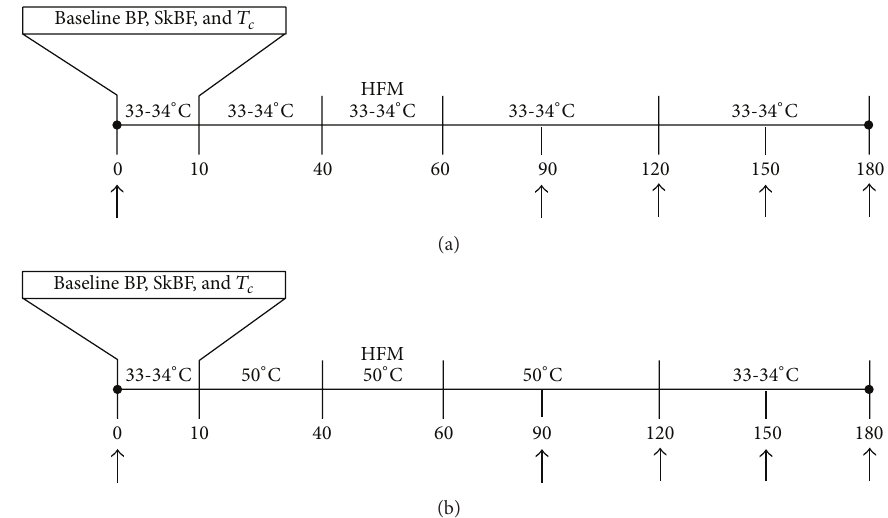
Figure 1: Schematic illustration of the experimental protocol. (a) HFM (thermoneutral) protocol and (b) HFM-TT protocol. Arrows indicate time points where finger stick blood samples were taken. Temperatures of 33-34 ∘ C (thermoneutral) and 50 ∘ C (thermotherapy) indicate the temperature of the water pumped through water-perfused suit. BP: blood pressure; SkBF: skin blood flow; 𝑇 𝑐 : core temperature; HFM: high fat